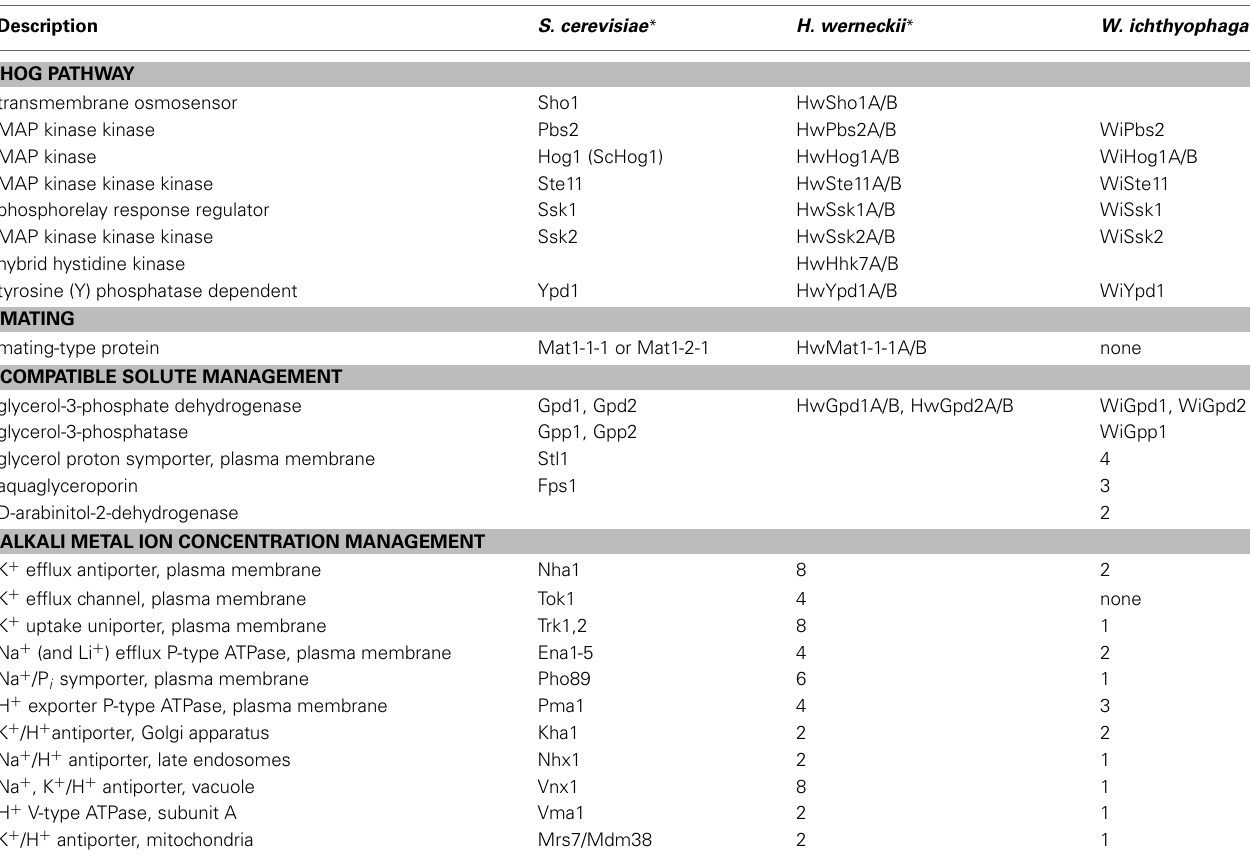
Table 2 | Major proteins, identified in H. werneckii and W. ichthyophaga and presumably involved in adaptation mechanisms to increased